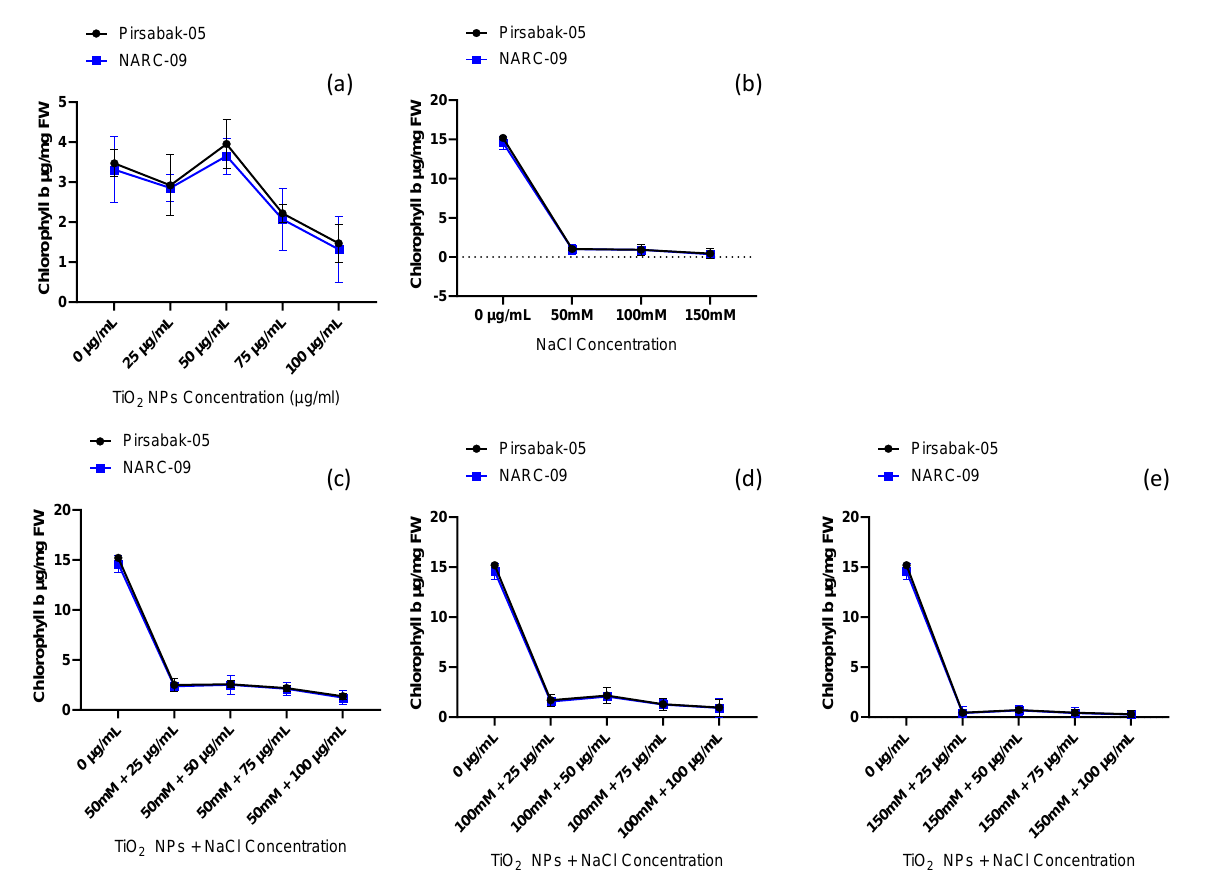
Figure 5. Effects of biogenic TiO 2 NPs on the chlorophyll b. content of selected wheat varieties under salinity stress conditions; ( a ) Effect of different concentrations of biogenic TiO 2 NPs on wheat varieties, ( b ) Effect of different concentrations of NaCl on wheat varieties, ( c – e ) Effect of different concentrations of TiO 2 NPs under varied concentrations (i.e., 50 mM, 100 mM, and 150 mM of NaCl). The data are represented in the form of means, while p was kept at p ≤ 0.05.